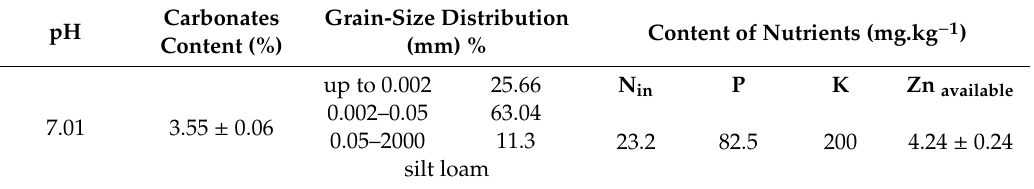
Table 1. Selective soil characteristics from the experimental locality before experimental trials.